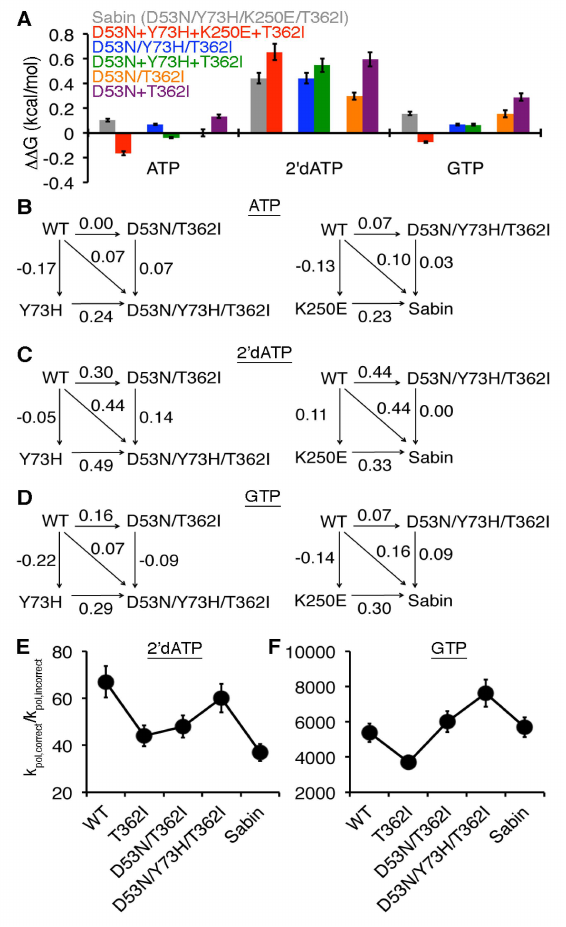
Figure 4. The Sabin I amino acid substitutions are cooperative. ( A ) Comparisons of single-substituted variants with multi-substituted variants. In this case, ∆∆ G X = RT ln(( k pol / K d,app ) X /( k pol / K d,app ) WT ) where X is a particular enzyme variant. The ∆∆ G result for the Sabin variant with all four amino acid substitutions (D53N/Y73H/K250E/T362I) is in grey, and is compared to the sum of the effects for all four single variants in red ( i.e. , ∆∆ G(D53N) + ∆∆ G(Y73H) + ∆∆ G(K250E) + ∆∆ G(T362I)). Likewise, the ∆∆ G result for the triple variant D53N/Y73H/T362I is in blue and is compared to the sum of the effects for the three single variants in green. The ∆∆ G result for the double variant D53N/T362I is in orange and is compared to the sum of the effects for the two single variants in purple. The ∆∆ G values for the multi-variants are also compared using thermodynamics cycles when ( B ) ATP, ( C ) 2 1 -dATP, and ( D ) GTP are the incoming nucleotides (templated against U); all values are reported as kcal/mol. On the left, the ∆∆ G values for the triple variant D53N/Y73H/T362I are compared to those of the double variant D53N/T362I and single variant Y73H. On the right, the ∆∆ G values for Sabin variant with all four amino acid substitutions are compared to those of the triple variant D53N/Y73H/T362I and single variant K250E. ( E ) Sugar and ( F ) nucleobase selectivities are also compared between WT, T362I, D53N/T362I, D53N/Y73H/T362I, and the Sabin